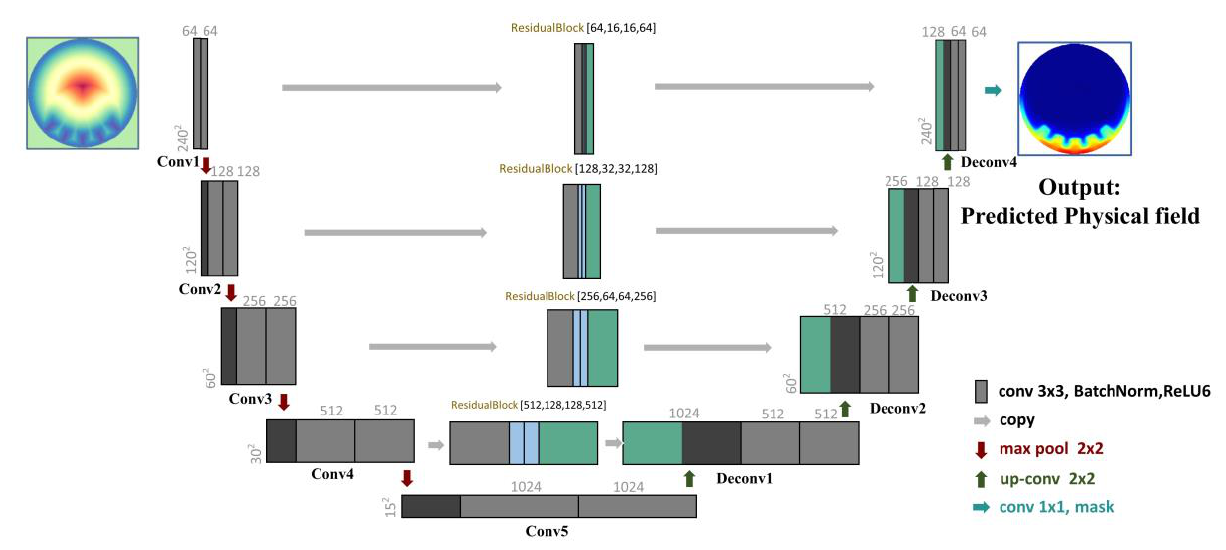
Figure 5. The detailed structure of the proposed deep CNN-based ROM for field prediction.